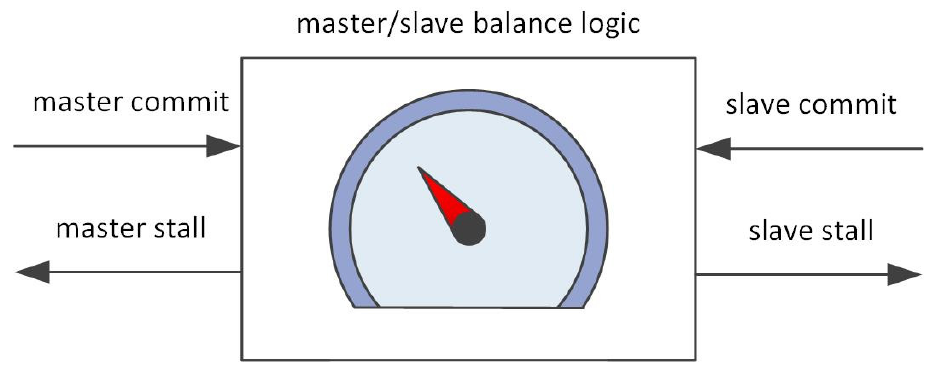
Figure 5. VDCLS Controller Module simplified block diagram.